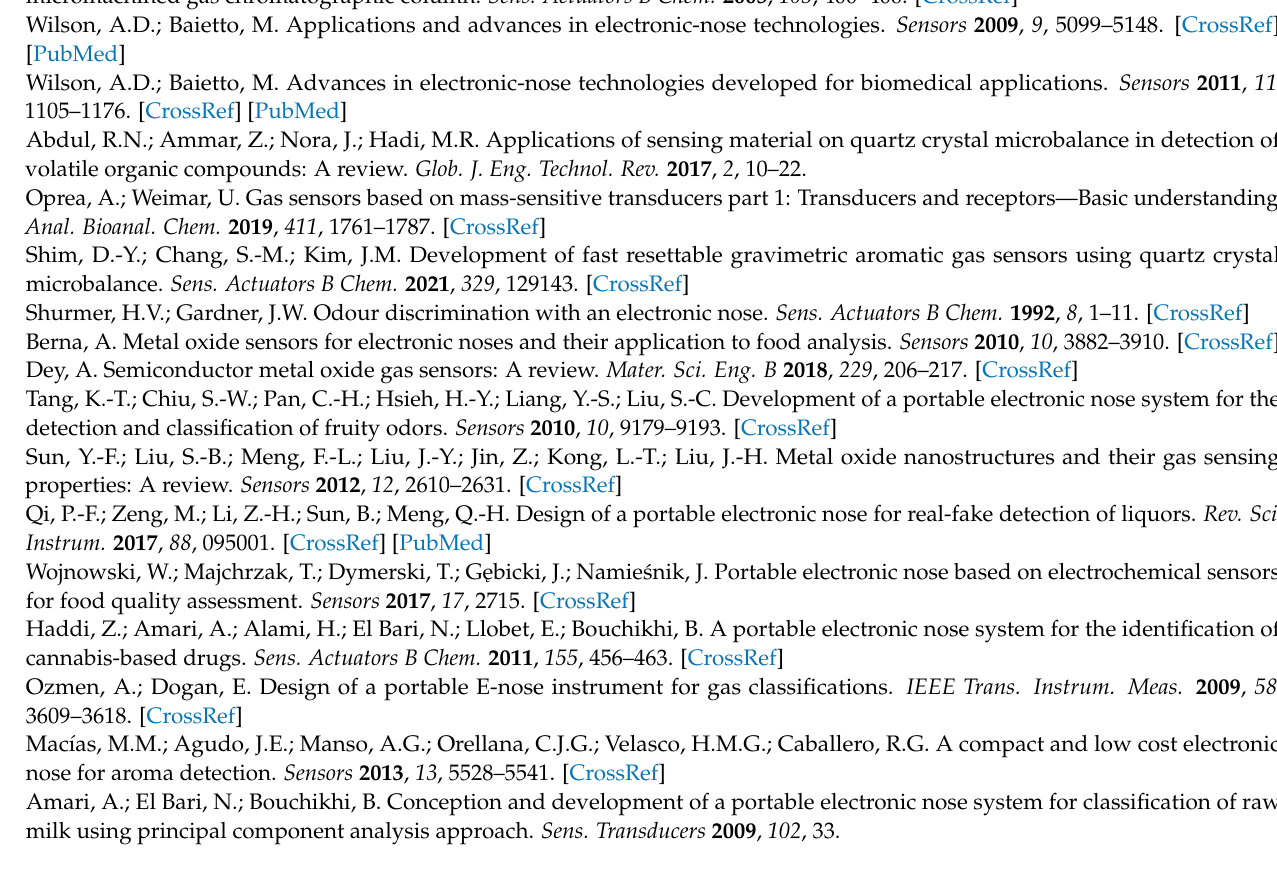
sample. Figure S3: Scatterplot of four different wine samples depicted by two sensors: TGS822 and MQ2. Figure S4: (A) Confusion matrix and (B) area under the curve graph for classification of wine